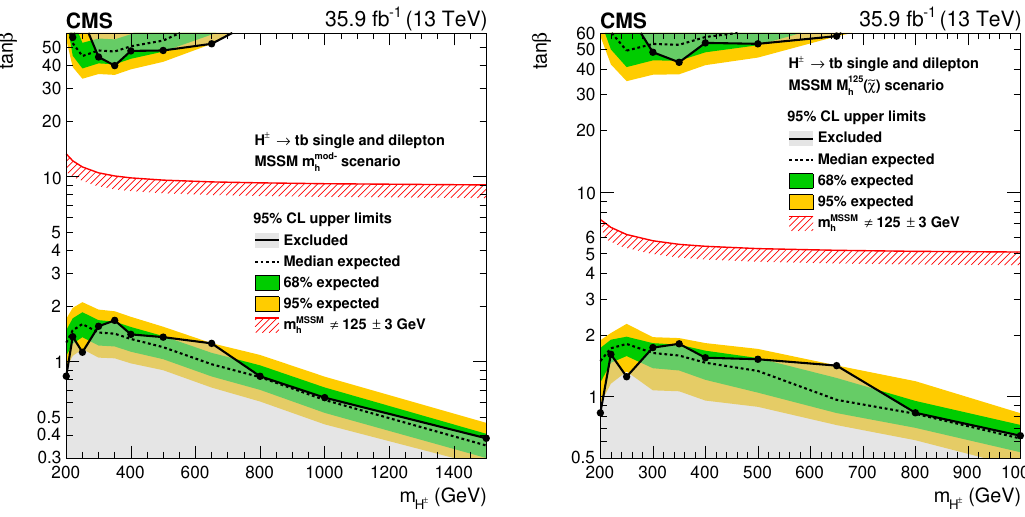
Table 3 . The upper limits at 95% CL on the (cid:27) (cid:12)nal states combined. The one (two) standard deviations (s.d.) from the expected median are also reported.